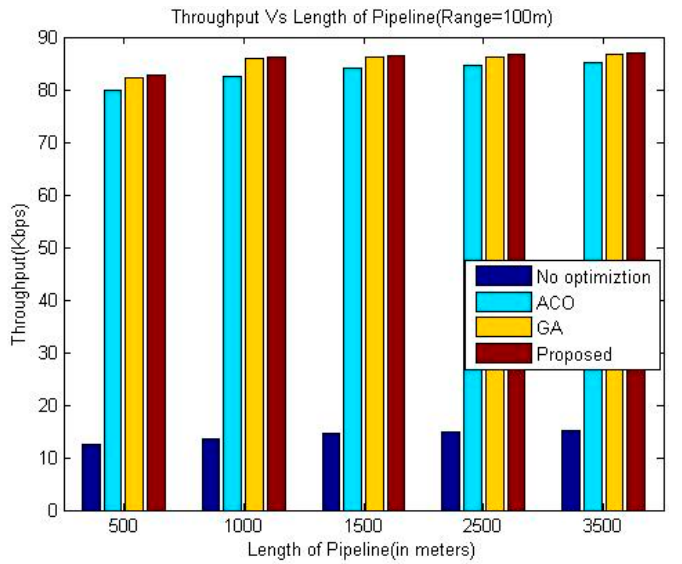
Figure 7. Comparison of Throughput (Range 50 m).